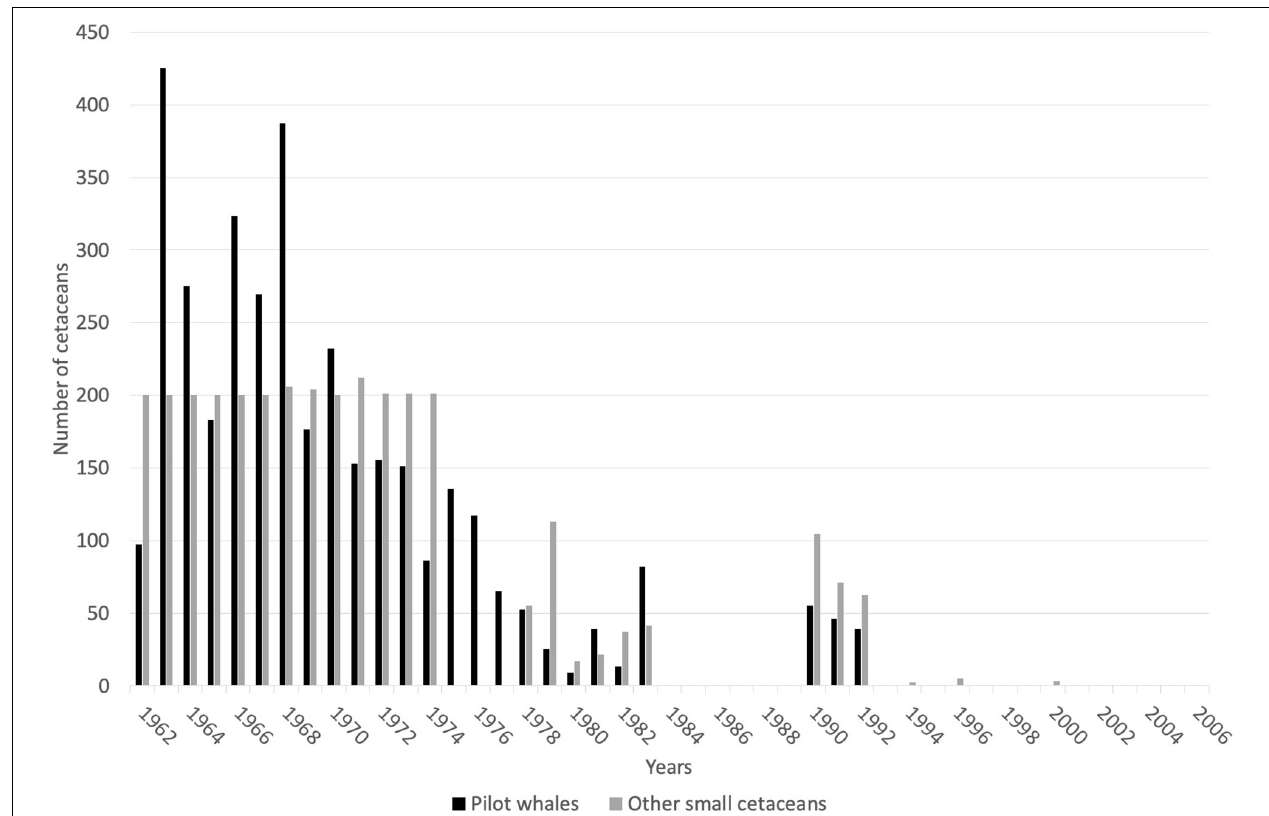
FIGURE 2 | Catch records for small cetaceans taken by whalers based at Barrouallie, St. Vincent, for the period 1962–2006. Gaps represent no data, not zero cetaceans taken. References: Caldwell and Caldwell (1975), Price (1985); Scott (1995), Bolaños-Jiménez et al. (2014).